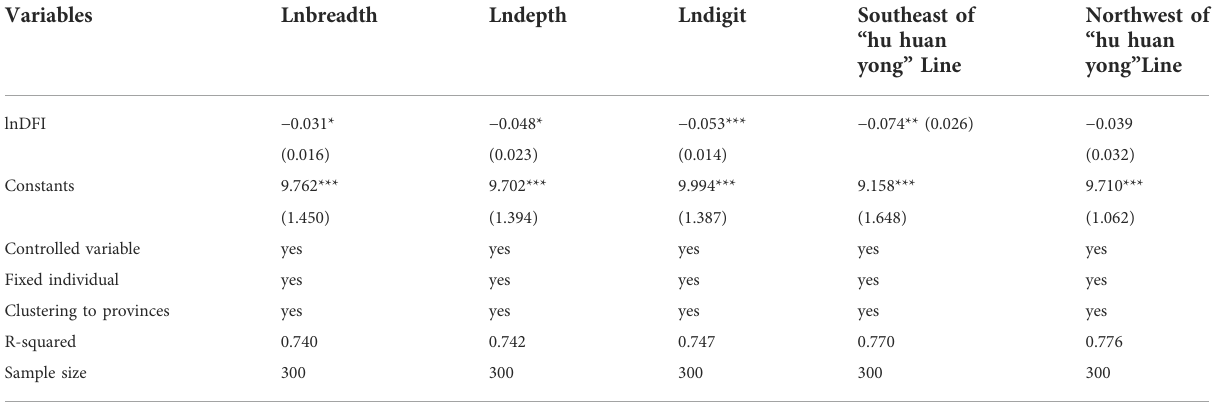
TABLE 6 Heterogeneity test results.